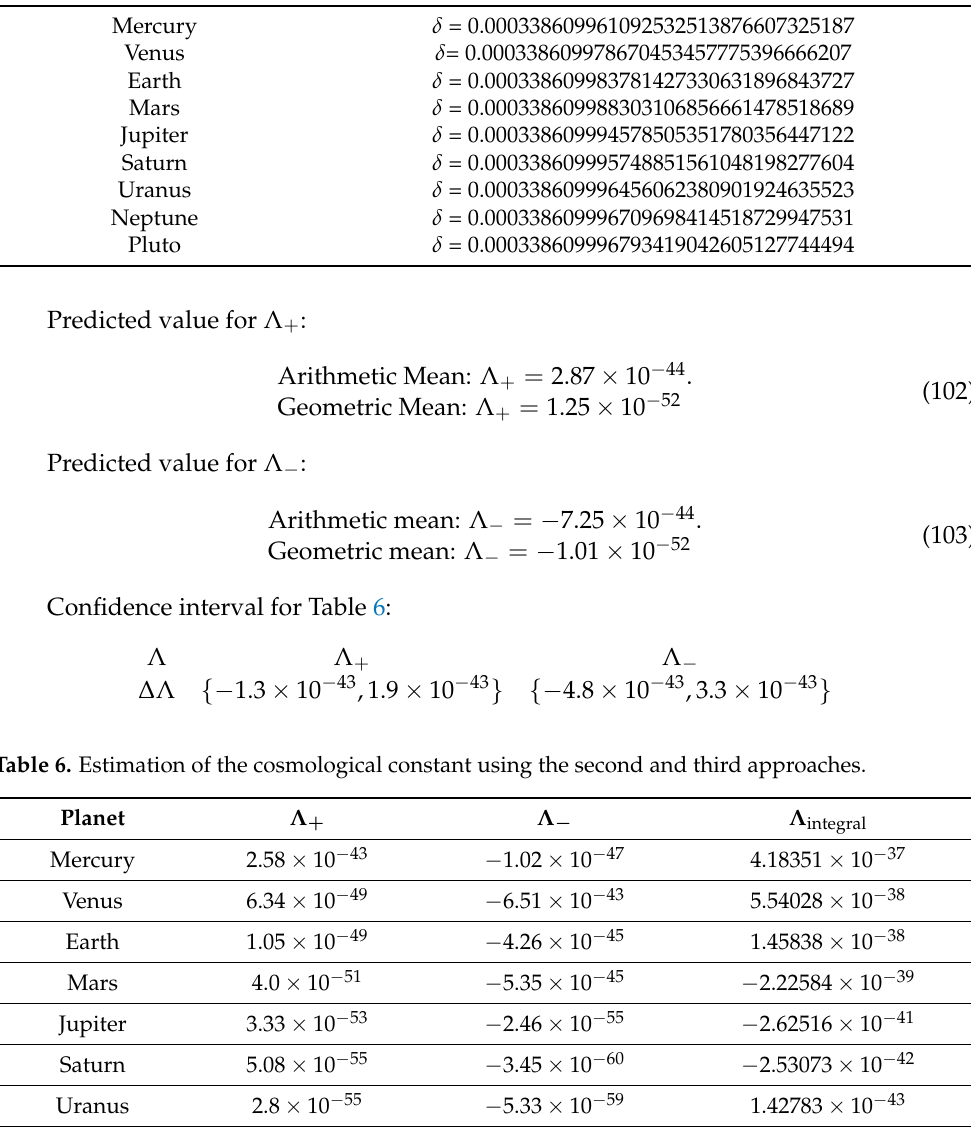
Table 5. δ value in Equation (72) .